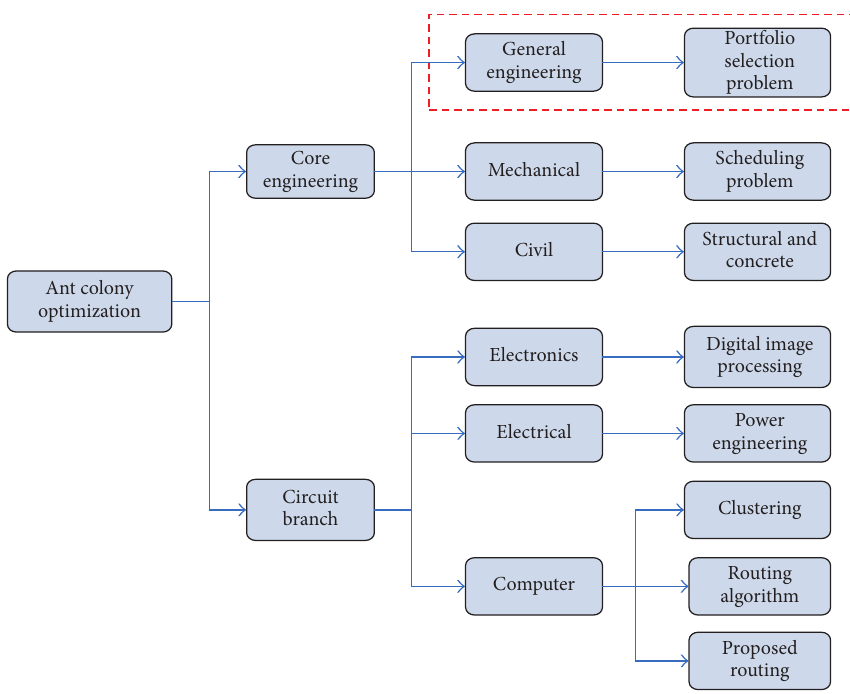
Figure 1: The main applications of ACO algorithm in recent years.